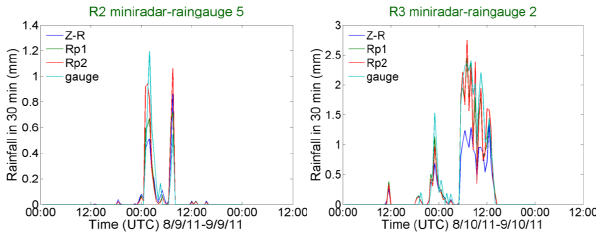
Figure 11. Time series of mini-radar rainfall estimates (accumulation in 30 minutes) from the three retrieval algorithms, expressed by Eqs. (1)-(3).